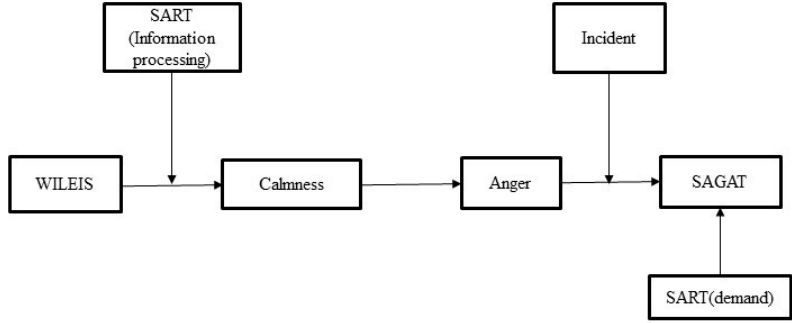
Figure 7. Conditional process model